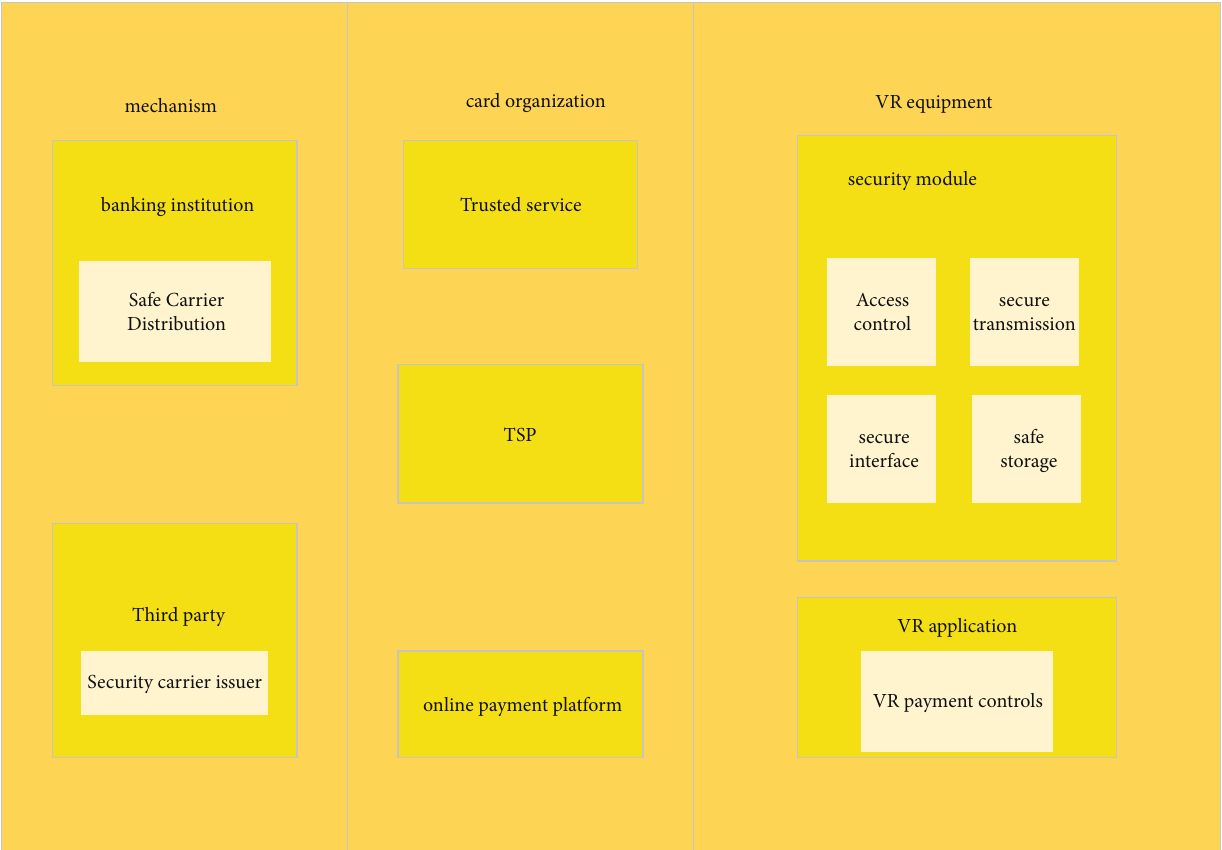
Figure 2: Technical architecture diagram.